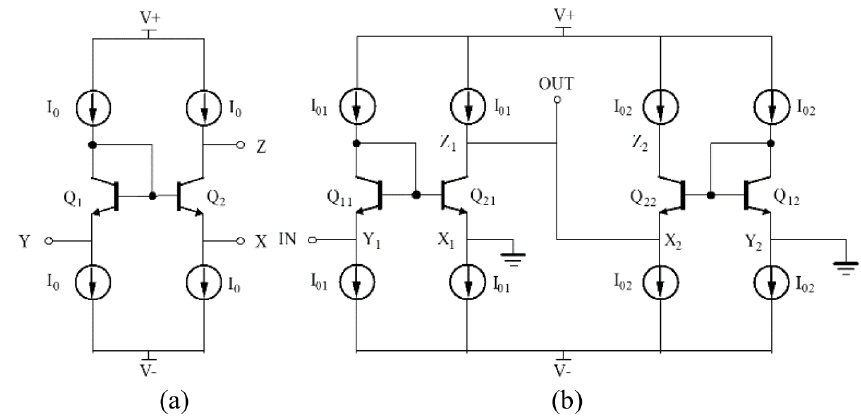
Figure 2. Class-A CCCII basic schematic ( a ) and topology of a voltage-mode amplifier using two basic class-A blocks ( b ).